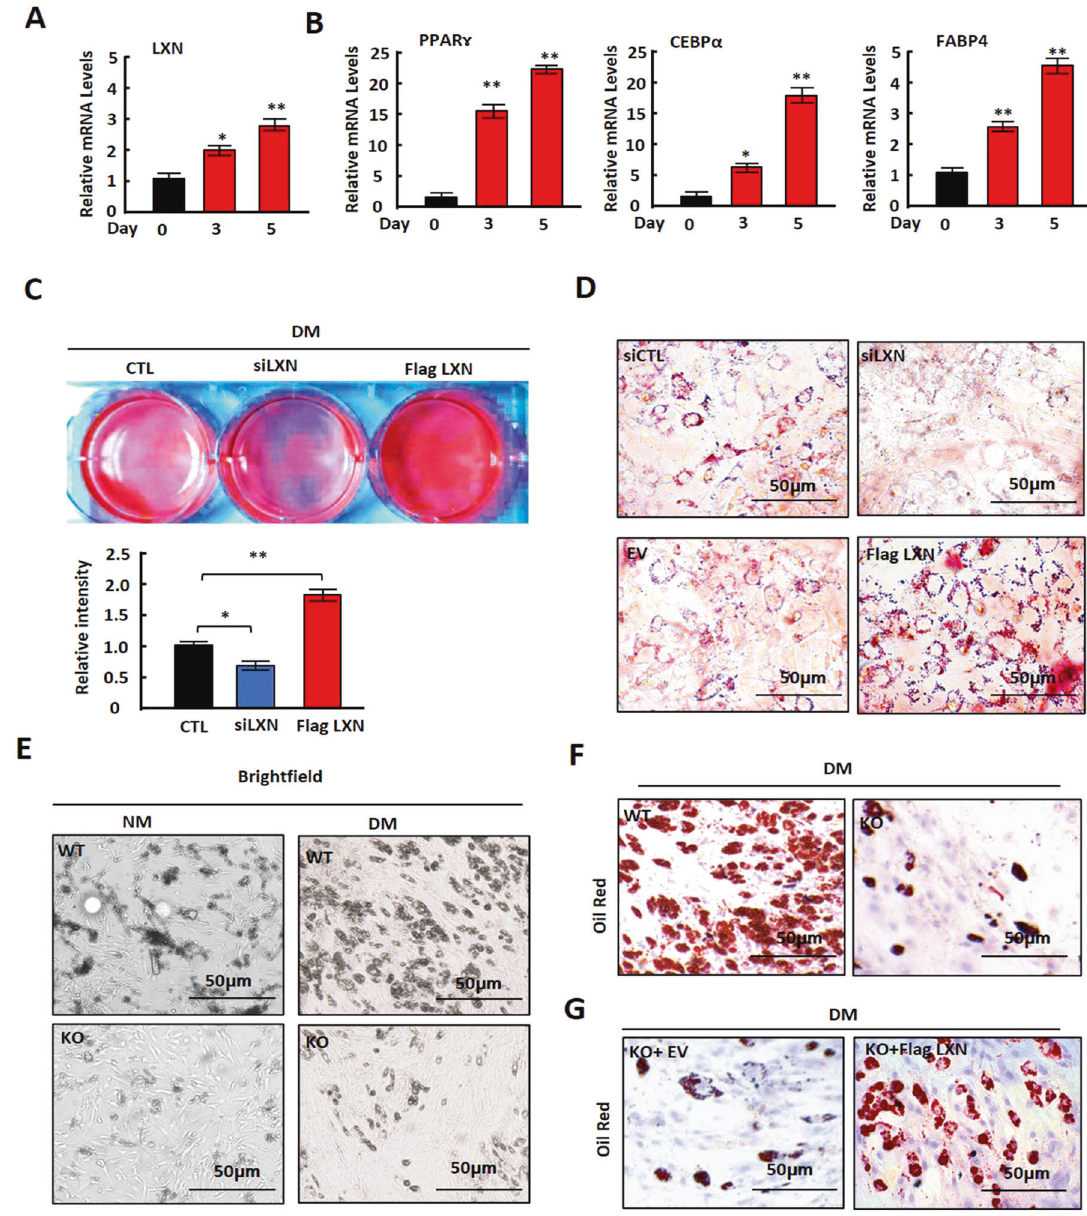
Fig. 3 LXN de fi ciency inhibits adipocyte differentiation and adipogenesis in vitro. A , B 3T3-L1 cells were cultured with differentiation medium for 0,3 and 5 d, the mRNA level of LXN ( A ), PPAR ɤ , CEBP α and FABP4 ( B ) were determined by qPCR. C , D 3T3-L1 cells were transfected with LXN siRNA or fl ag-LXN plasmid. After 48 h, the cells were cultured with differentiation medium for 3 d. Cultured cells were subjected to Oil Red O staining ( C ) and imaged by EVOS microscope ( D ). EV empty vector, siCTL siRNA control, Scale bar = 50 μ m. E , F WT and LXN − / − preadipocytes (KO) were cultured with differentiation medium for 3 d ( E ). Cultured cells were subjected to Oil Red O staining ( F ). Scale bar = 50 μ m. G LXN − / − preadipocytes were transfected with fl ag-LXN plasmid or empty vector. The cells were cultured with differentiation medium for 3 d, and subjected to Oil Red O staining. Scale bar = 50 μ